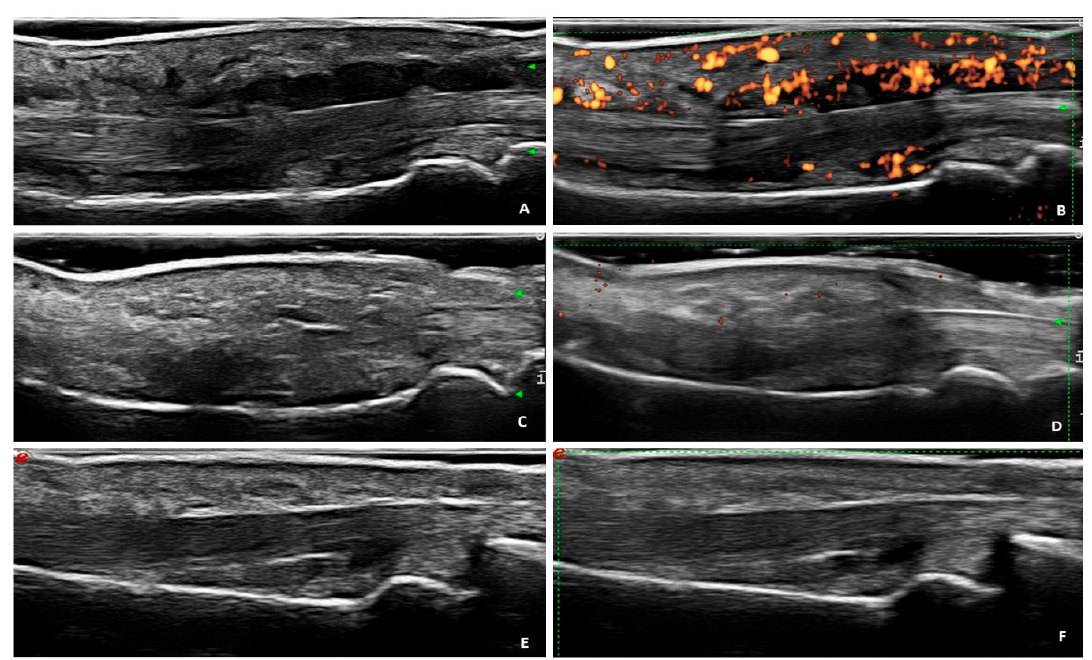
Figure 1. ( A , B ) Volar scan of a dactylitic digit showing flexor tenosynovitis (grade 3 for GS and PD) and soft tissue oedema (grade 2 for GS and PD) at baseline. ( C , D ) Longitudinal views of the contralateral, unaffected digit. ( E , F ) Volar scan of dactylitic digit after three months showing the absence of flexor tenosynovitis and soft tissue oedema (both in GS and PD. Dorsal scans are not shown because joint synovitis and peritendon extensor inflammation were not present. Abbreviations: GS: grey scale; PD: power Doppler.